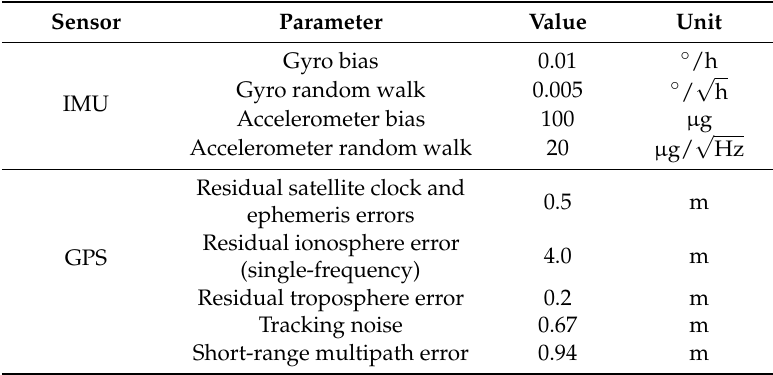
Table 1. Inertial measurement unit (IMU) and GPS specifications [23].